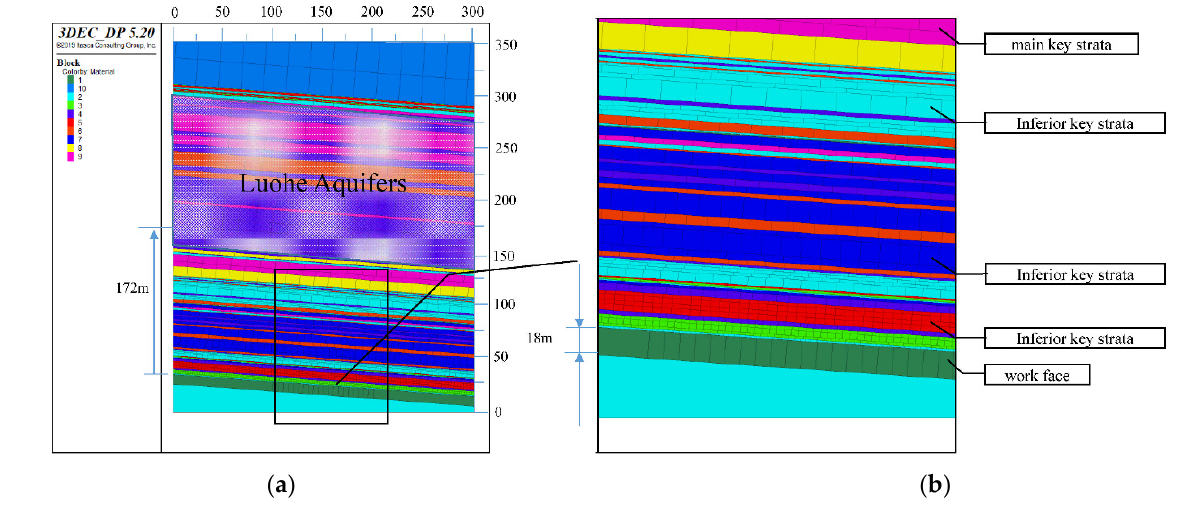
Figure 6. Numerical model diagrams. ( a ) The whole model, ( b ) local amplified details. Table 3. Physical and mechanical parameters for modelling.